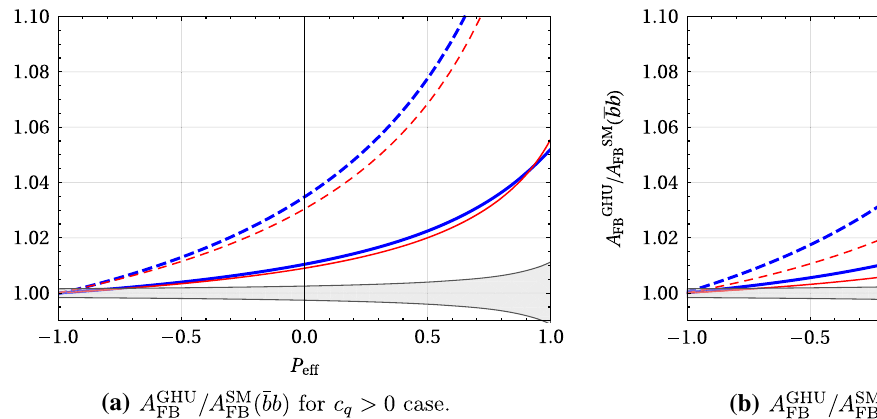
respectively. Blue-thick and red-thin lines correspond to θ H = 0 . 10 and 0 . 08, respectively. The gray band indicates the statistical uncertainty at √ s = 250 GeV with 250 fb − 1 data